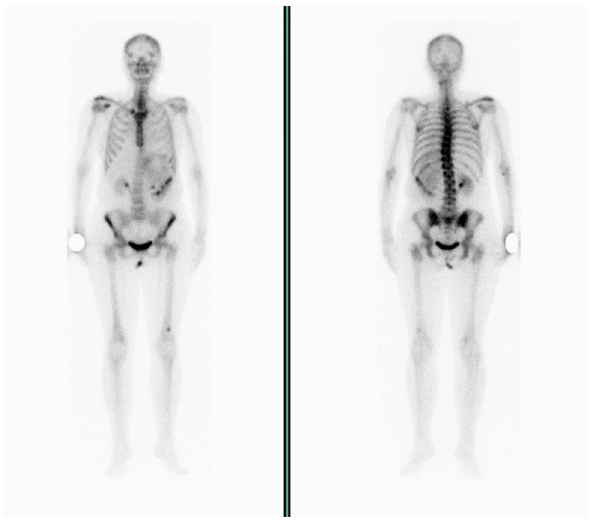
Figure 2: Total body bone scan performed for staging revealed no bone